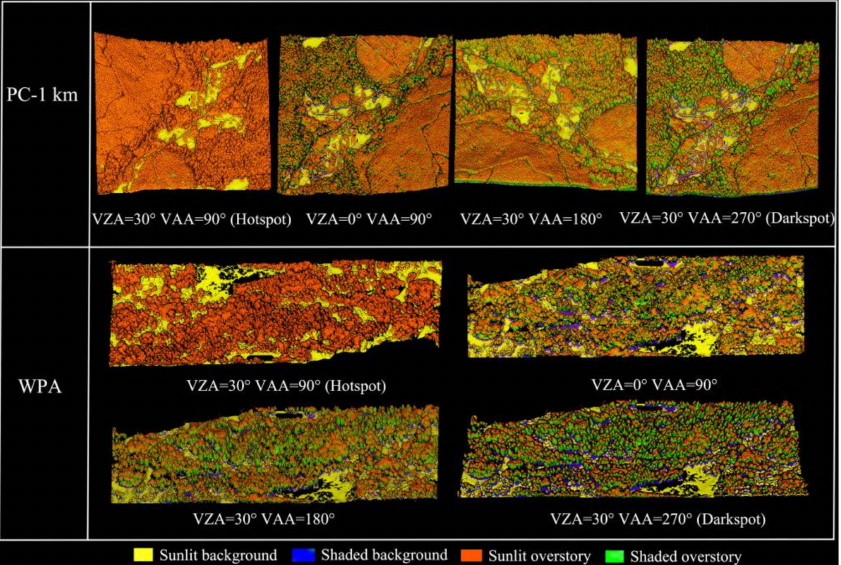
Figure 6. The ALS-based four forest component results at the landscape level in PC (upper) and WPA (below) sites. View zenith angle (VZA) and View azimuth angle (VAA) represent view zenith angle and view azimuth angle,